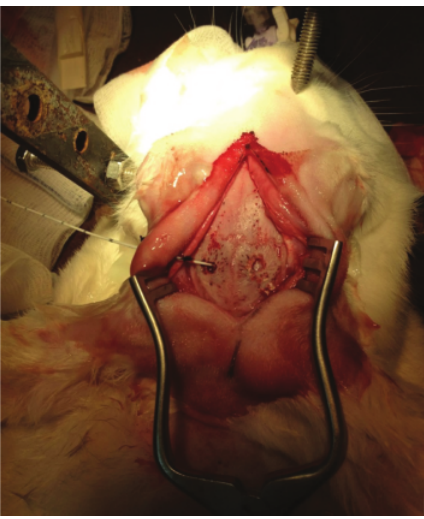
Figure 3: Intraprocedural image of the rabbit’s skull depicting the two burr holes and the insertion of the fiberoptic Camino